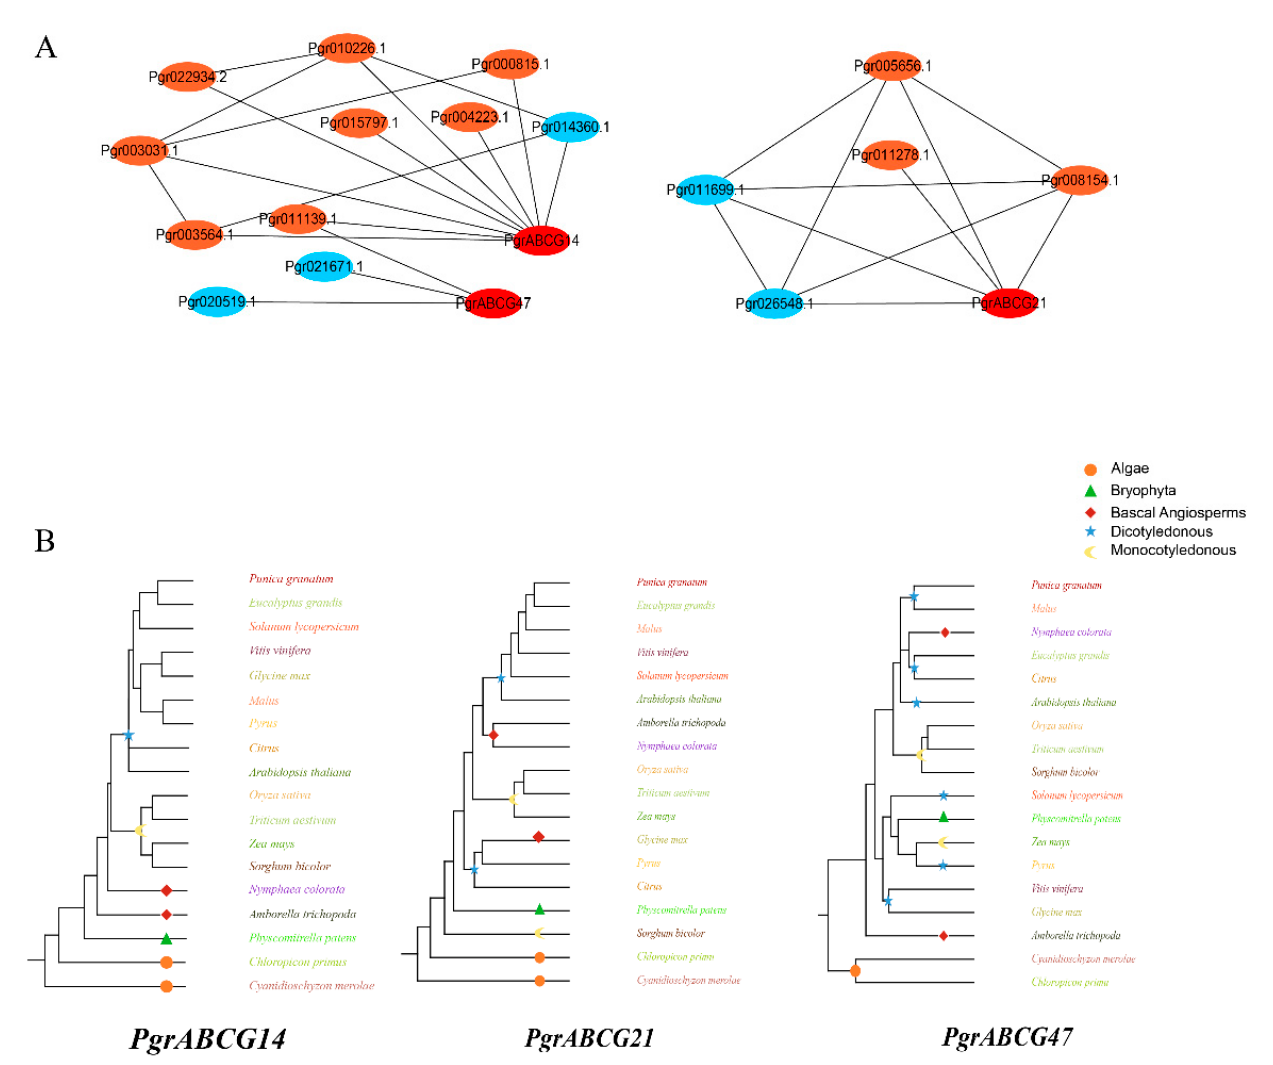
Figure 4. Co-expression network and evolution of the candidate PgrABCG genes. ( A ) The red dots represent PgrABCG genes, the blue dots represent genes involved in phenylpropanoid biosynthesis pathways, and the orange dots represent genes involved in hormone signaling pathways. ( B ) Rooted evolutionary trees of the candidate PgrABCG genes and the homologous genes in typical plant species. Different colors represent different plant